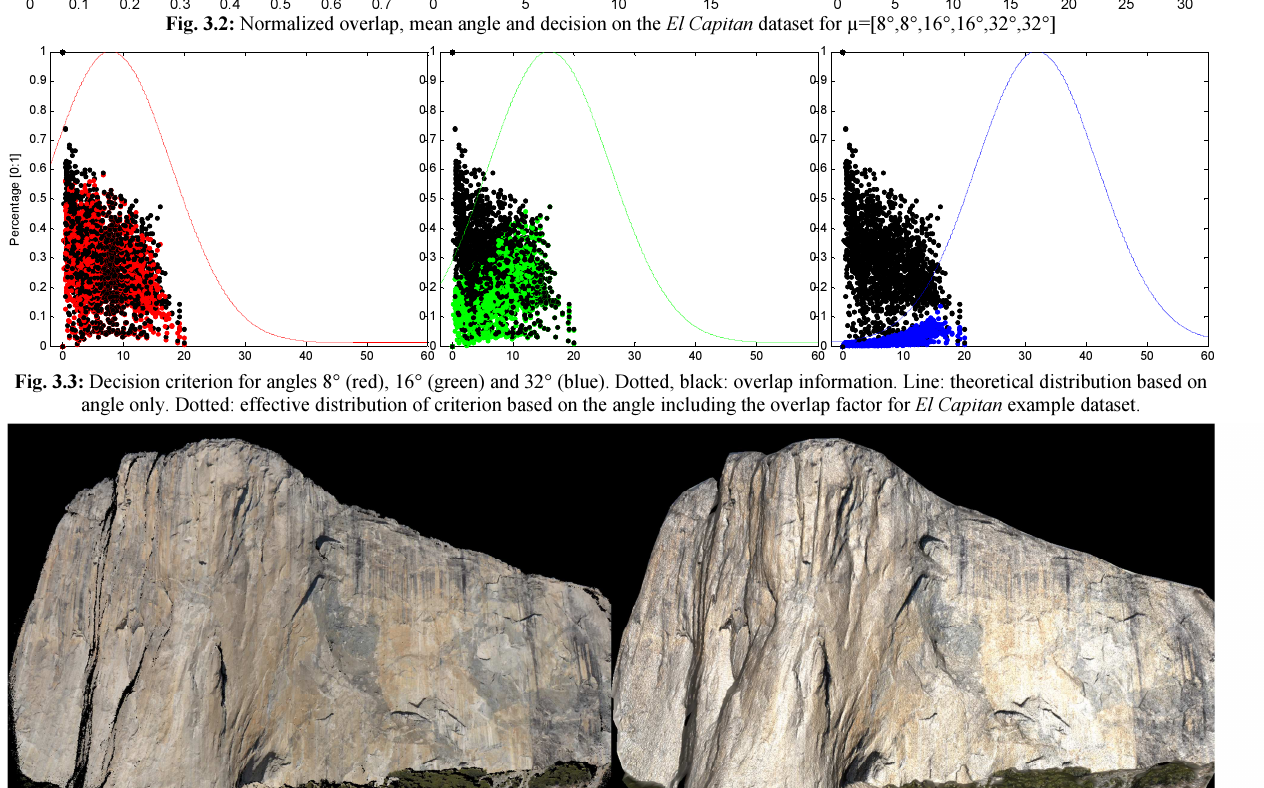
Fig. 3.2: Normalized overlap, mean angle and decision on the El Capitan dataset for µ=[8°,8°,16°,16°,32°,32°]